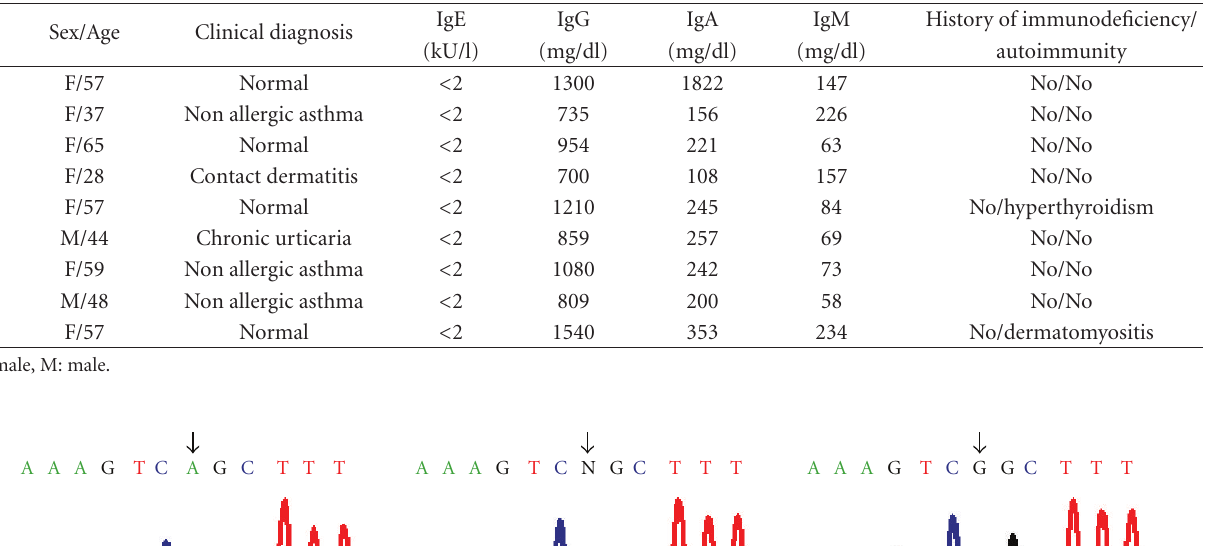
Table 2: Phenotype characteristics of patients with IgE hypogammaglobulinemia.